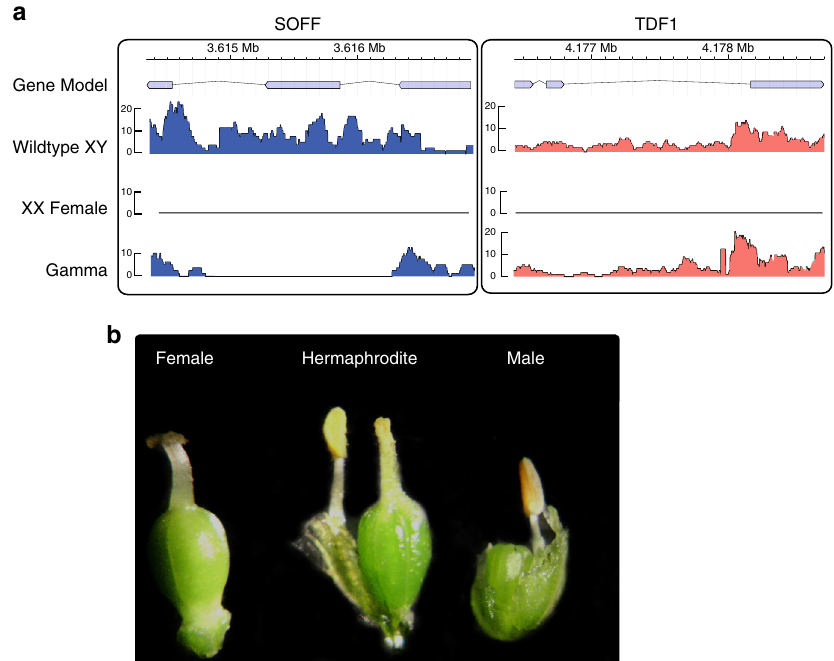
Fig. 2 Mutations in sex determination genes on the Y. a Read alignment coverage (read counts) across the SOFF and aspTDF1 gene models for an XY male (K323), a sibling XX female related to the YY assembled genome, and the gamma-irradiated G033 genotype. b Flowers from a spontaneous male-to-hermaphrodite mutant compared to wild-type male and female fl owers (Line3). A frameshift mutation was found in the SOFF CDS sequence (Supplementary Note